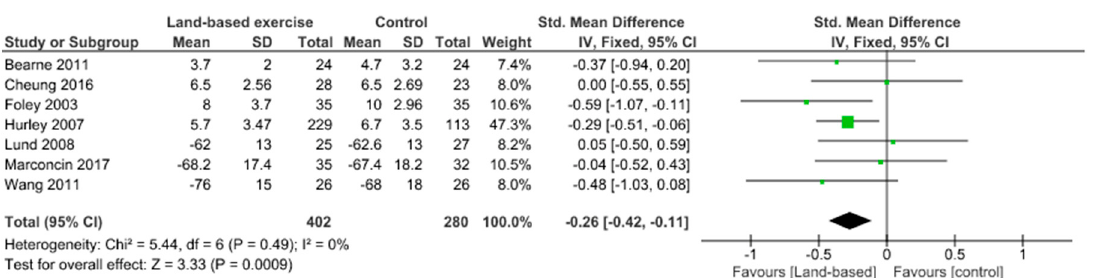
Figure 3. Pain: Aquatic exercise versus Control.